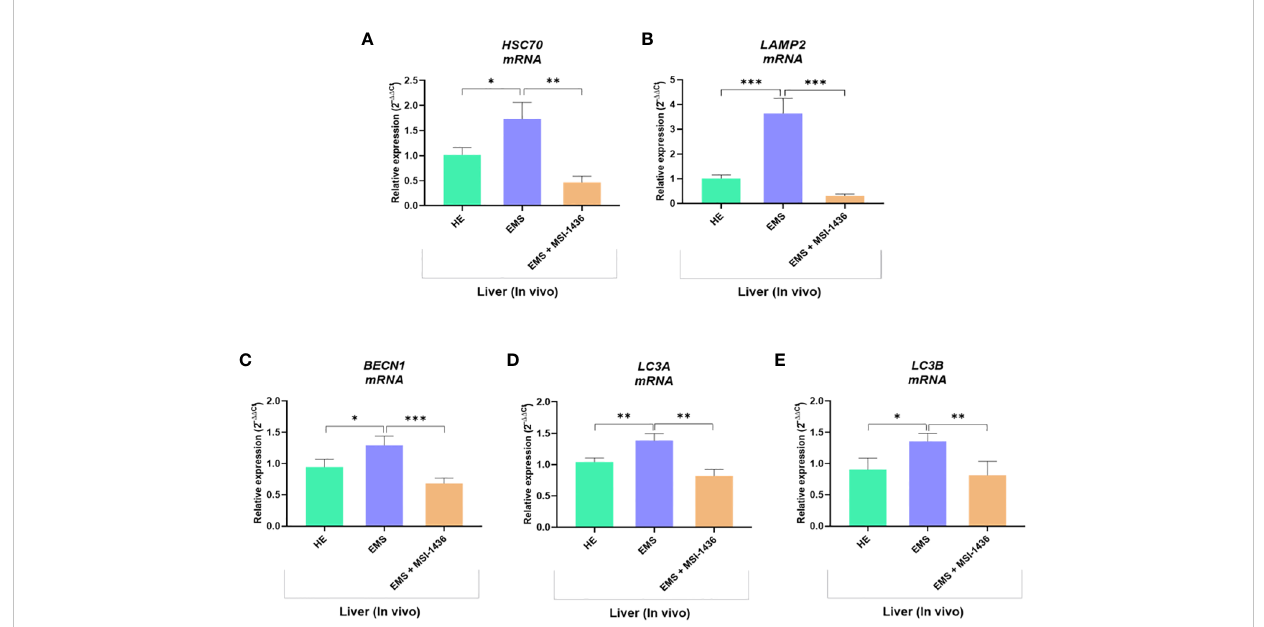
FIGURE 9 Expression of liver key autophagy associated mediators following in vivo application of MSI-1436 inhibitor. Relative gene expression of HSC70 (A) , LAMP2 (B) , BECN1 (C) , LC3A (D) and LC3B (E) were determined from healthy, EMS untreated and EMS treated horses. Data are presented as a mean value obtained from measurments ± SD. Statistical signi fi cance was marked as follows: *p-value < 0.05; **p < 0.01 and ***p-value <